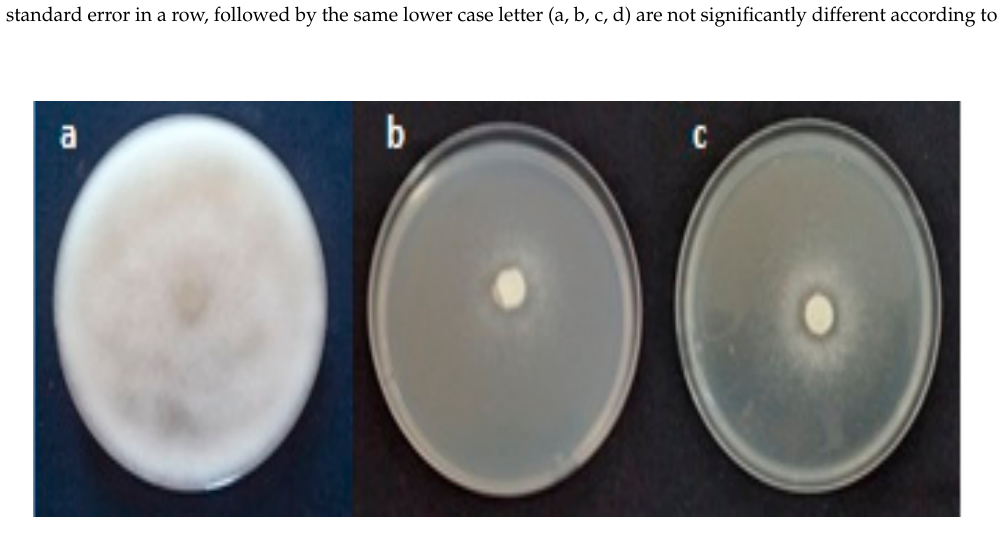
Figure 4. Inhibition of mycelial growth of Pythium ultimum in the presence of purified fractions F11 ( b ) and F17 ( c ) of Raphanus raphanistrum dichloromethane extract recorded after 3 days of incubation at 25 °C compared to the control ( a ).